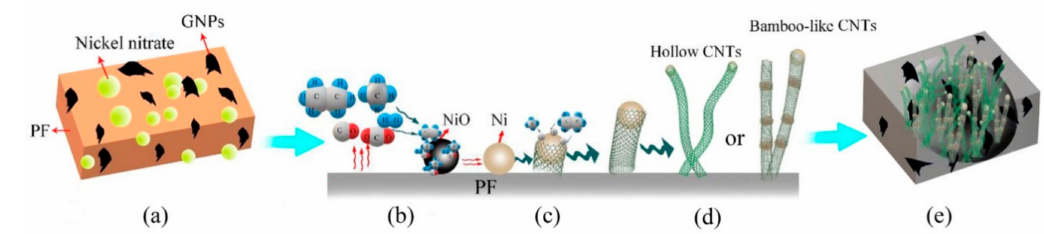
Figure 13. Schematic diagram of growth process of CNTs from catalytic pyrolysis of phenolic resin with Ni ( a ) The exfoliated GNPs / PF sample with 1 wt.% Ni(NO 3 ) 2 · 6H 2 O, ( b ) the formation of metallic Ni, reduced from the NiO by reductive atmosphere from the pyrolysis of the PF, ( c ) the precipitation of CNTs across the Ni bottom, ( d ) the growth of hollow or bamboo-like CNTs, ( e ) the formed CNTs were uniformly distributed in the pyrolyzed